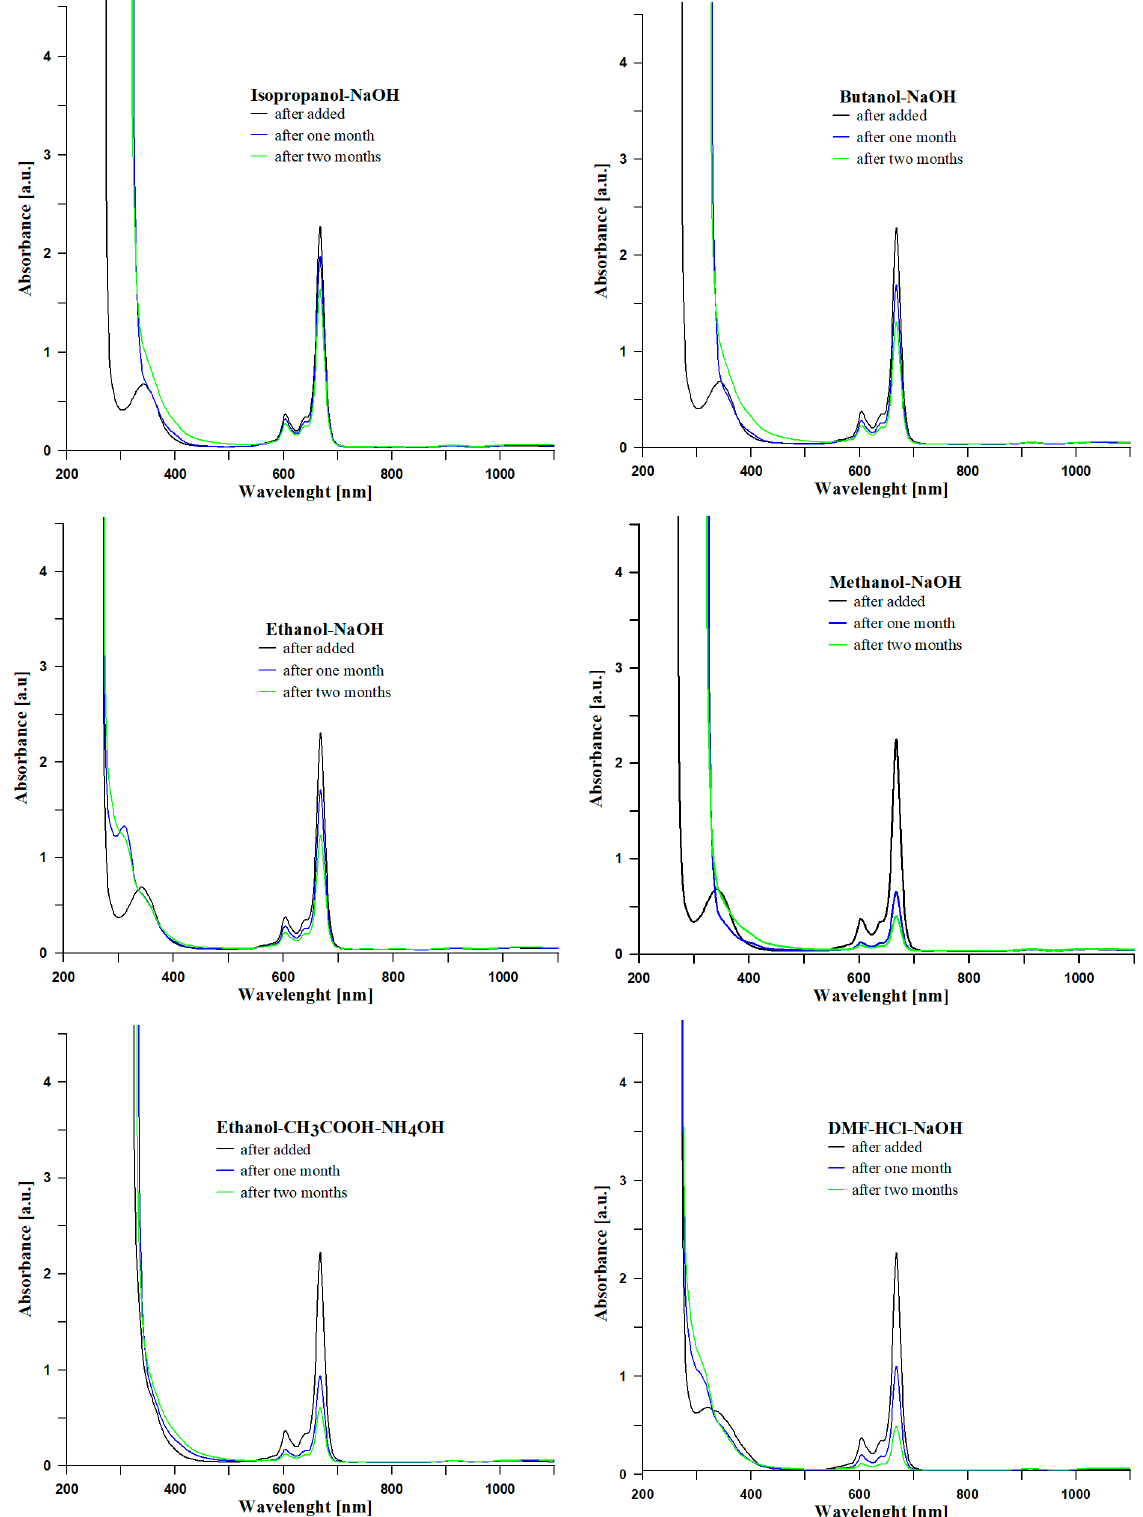
Figure 4. Evaluation of UV-Vis absorbance according to lifetimes.